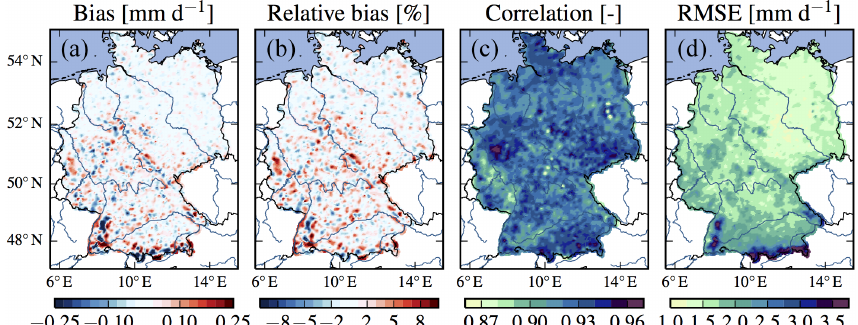
Figure A2. Evaluation of the interpolation at precipitation stations based on a leave-one-out cross-validation strategy, i.e., the Jackknife method. The performance criteria from the individual stations are interpolated to a 4km × 4km grid using ordinary Kriging. The panels denote different performance metrics: (a) bias, (b) relative bias, (c) Pearson correlation coefficient, and (d) root mean squared error (RMSE).